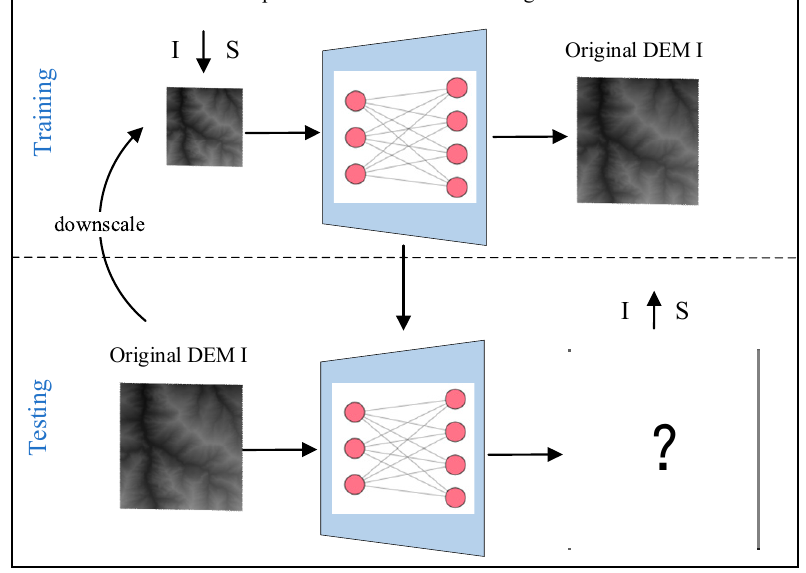
Figure 2. The processing flow of the feature reconstruction module.